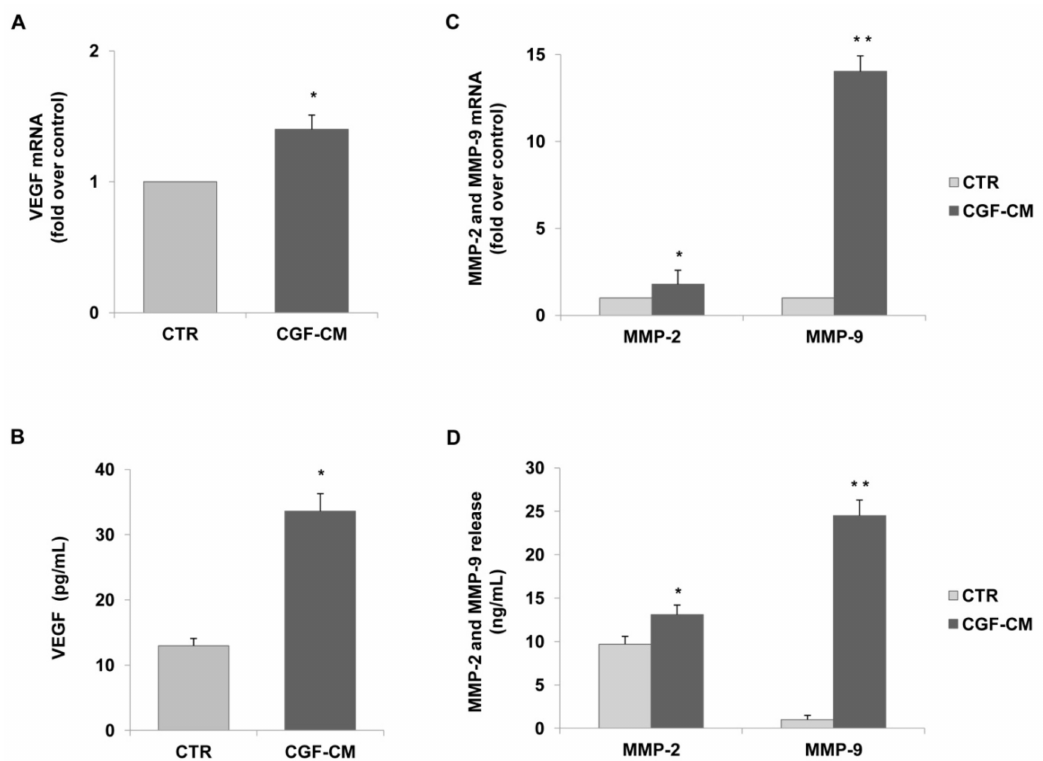
Figure 3. CGFs induce the expression and release of VEGF and matrix metalloproteinases in endothelial cells. HUVECs were incubated with CGF-CM (10%) or culture medium (CTR) for 4 h and mRNA levels of VEGF. ( A ) MMP-9 and MMP-2 ( C ) were analyzed by qRT-PCR and expressed as fold over unstimulated control (CTR) (mean ± SD). HUVECs were incubated with CGF-CM (10%) or culture medium (CTR) for 4 h, and then culture media were removed and replaced with fresh media for 48 h. Media were collected, and VEGF ( B ), MMP-9, and MMP-2 ( D ) concentrations were analyzed by ELISA. Data are representative of three independent experiments, expressed as means ± SD. Each experiment consisted of four replicates for each condition. * p < 0.05 and ** p < 0.01 vs. control (CTR).